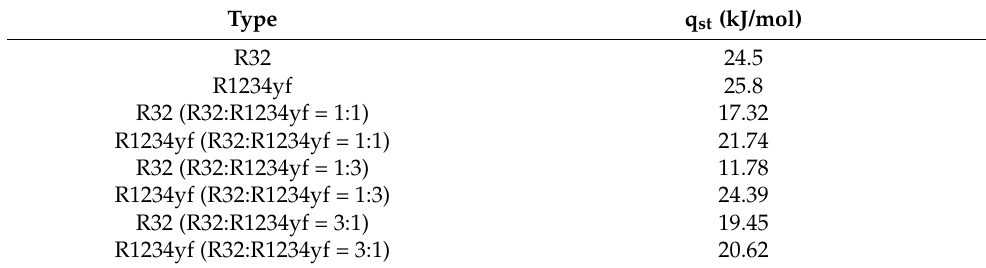
Table 4. The isostatic adsorption heat in MOF-200 .